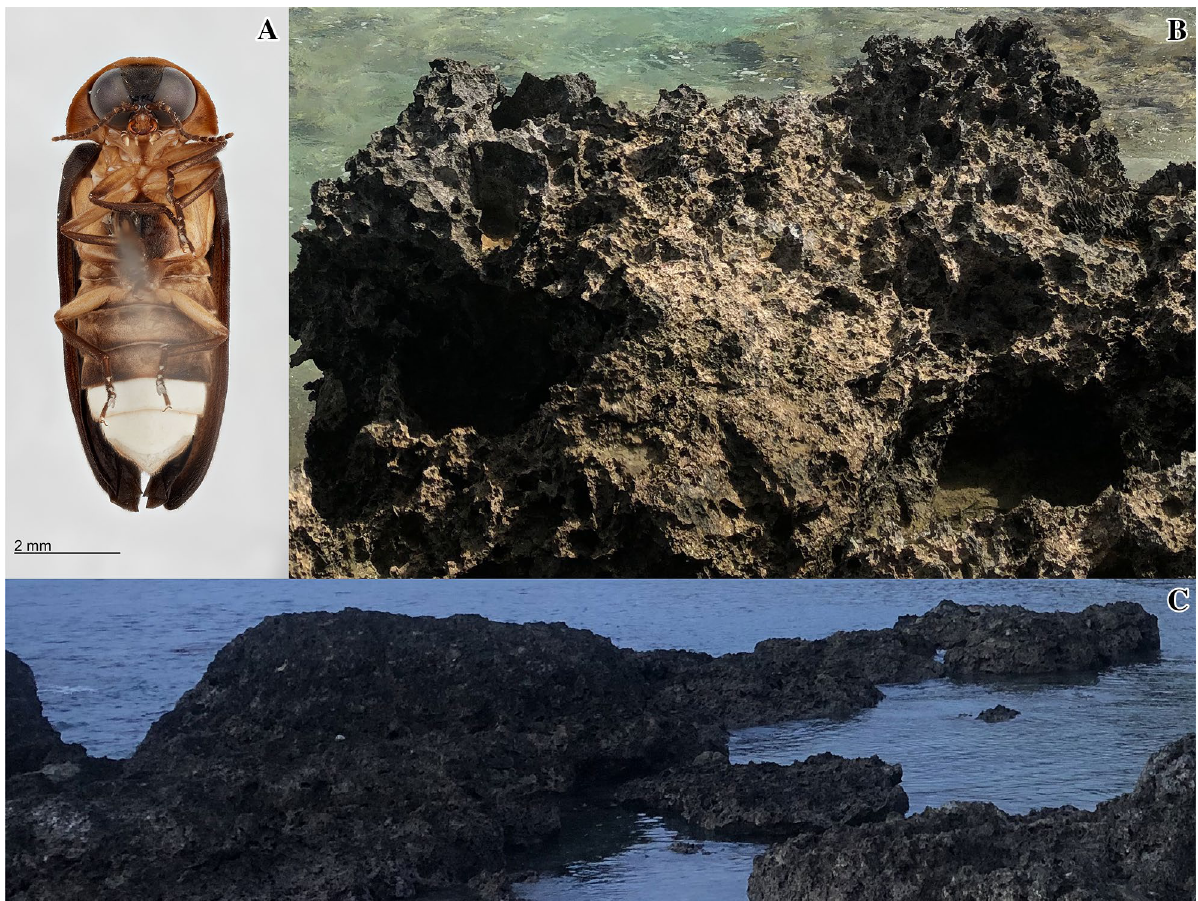
Figure 2. ( A ) Holotype of A. maritimus . ( B , C ) Photos of habitat, volcanic rock with extremely sharp and jagged edges lined the coast where Atyphella was collected. At high tide, the rocks were either mostly submerged or completely covered (Photo credit: ( A , B ) Colin Jensen and Natalie Saxton, ( C ) Saxton et al. 24